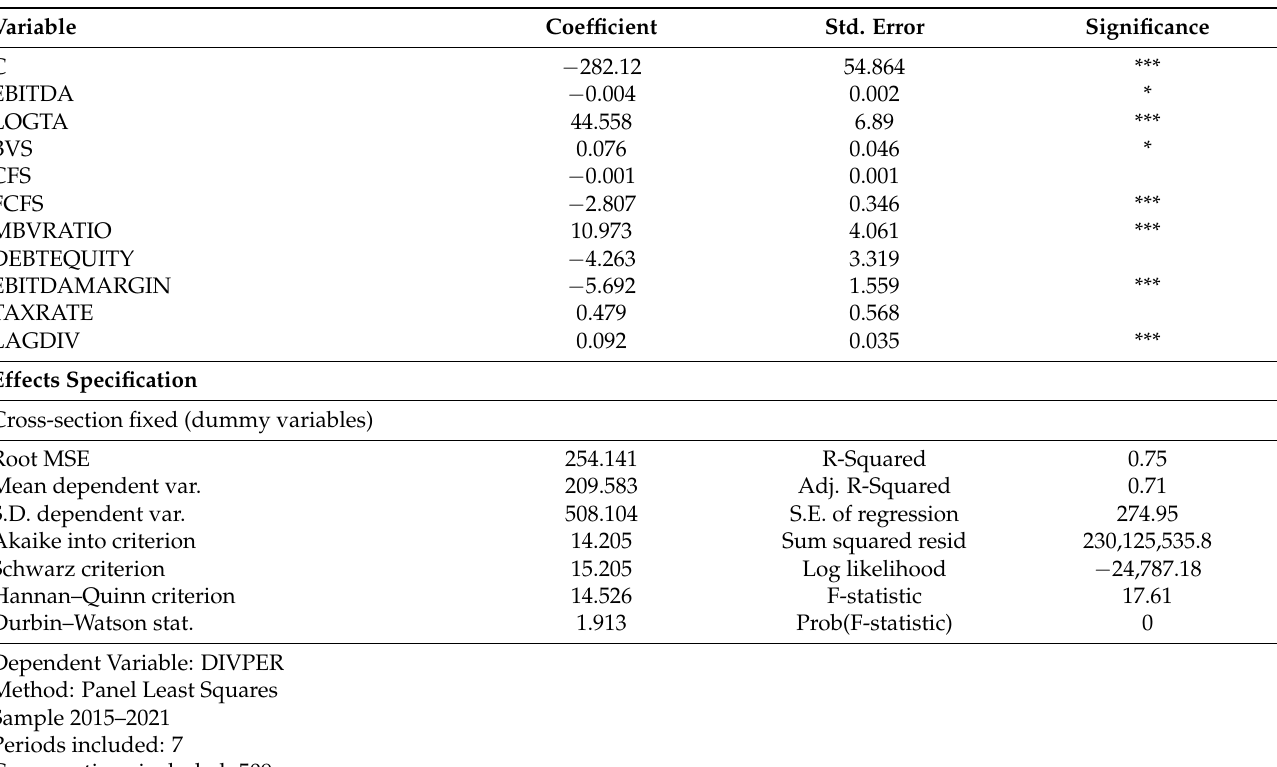
Table 6. Determinants of dividend